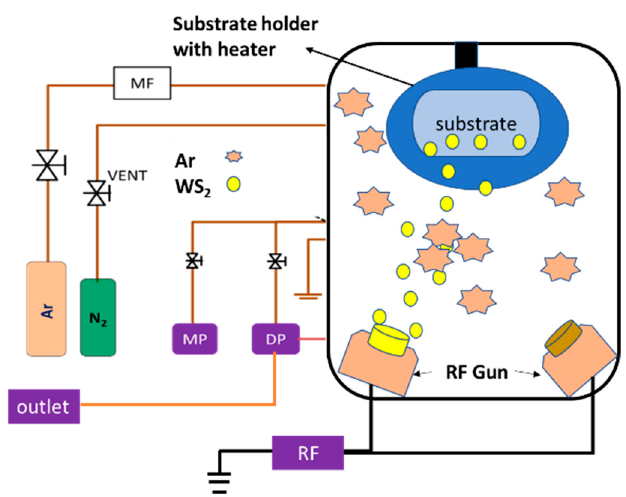
Table 1. WS 2 fabrication parameters.